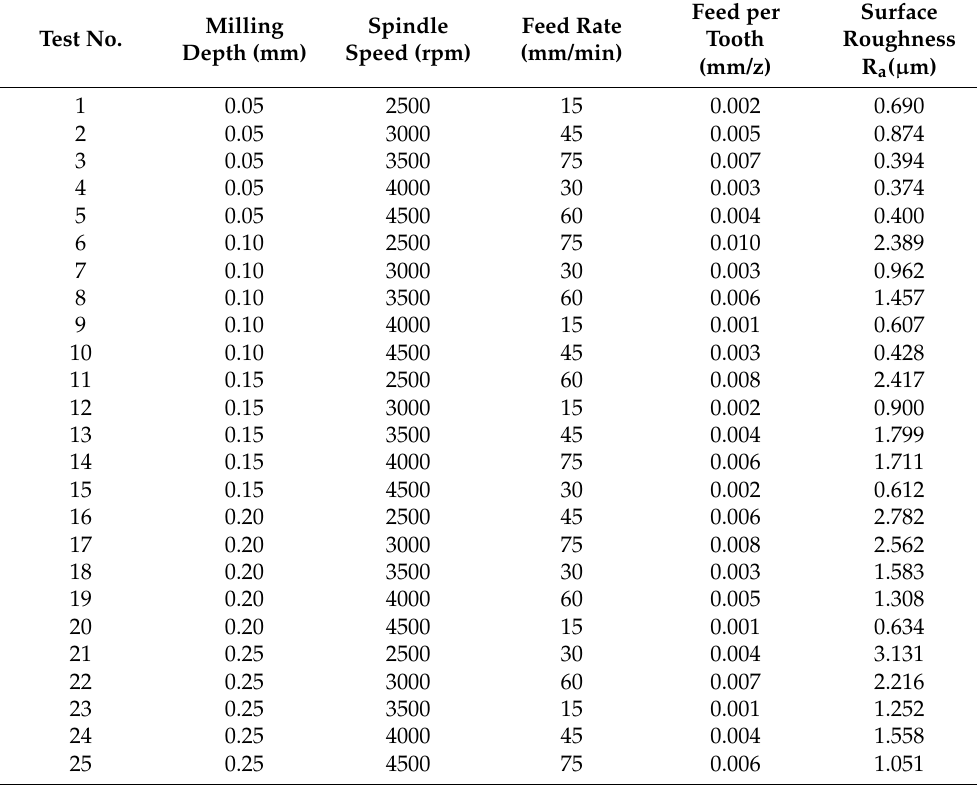
Table 8. The feed per tooth in each